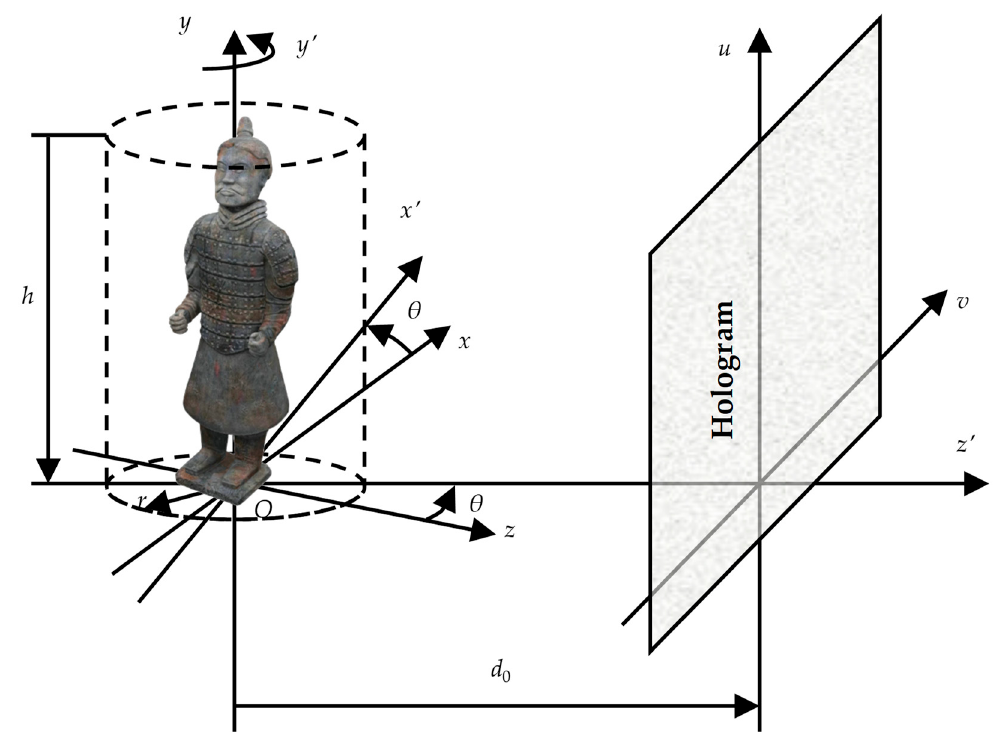
Figure 1. Coordinates for one-dimensional rotation transformation.